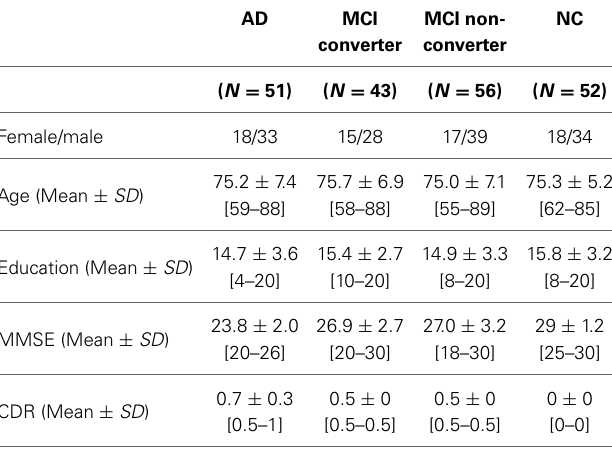
Table 1 | Demographic and clinical information of the